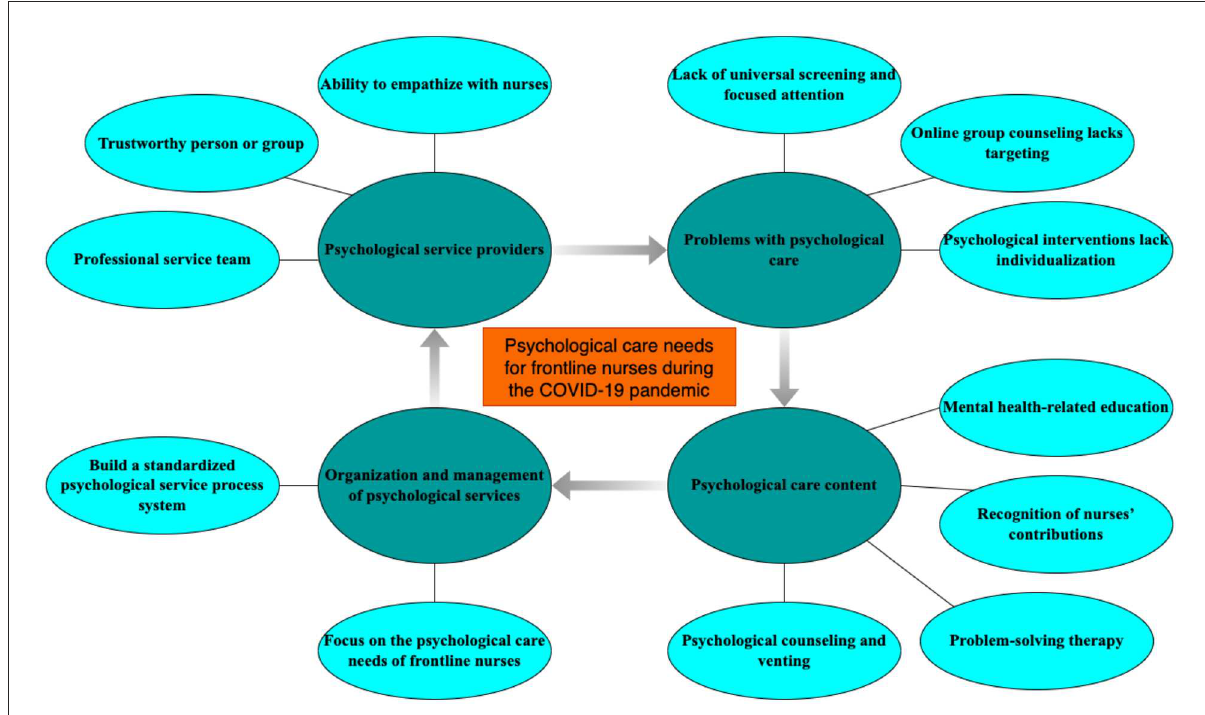
FIGURE1 Themes and categories of psychological care needs for frontline nurses during the COVID-19